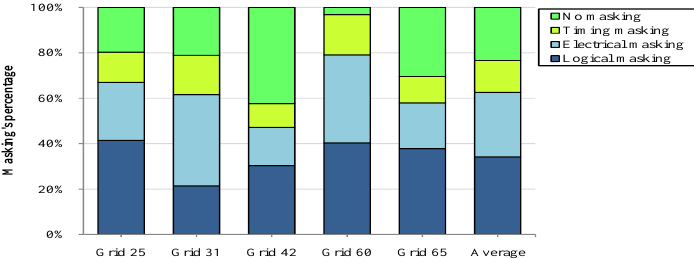
Figure 8. Particular grids of s15850 and the percentage of the injected errors that become logically, electrically and timingly masked.